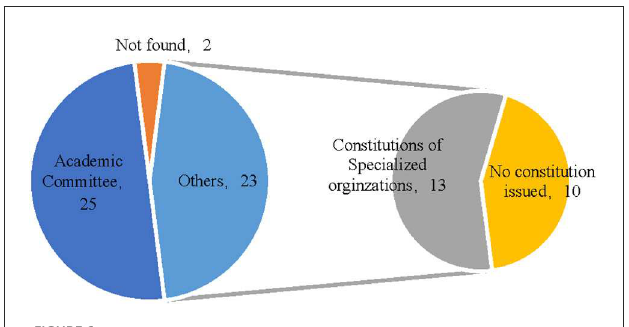
FIGURE6 Statistics on the promulgation of RI management organizations and charters in